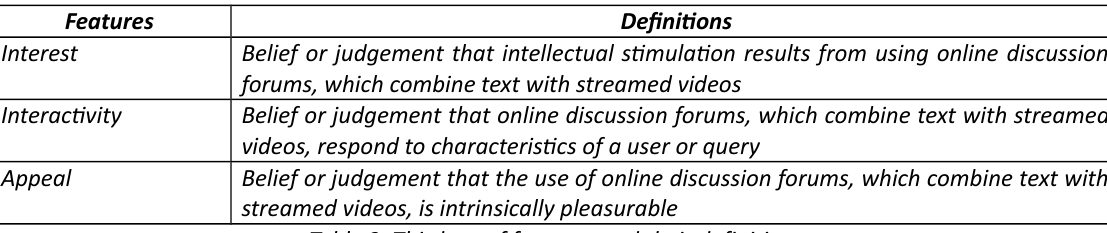
Table 2. Third set of features and their defnitons